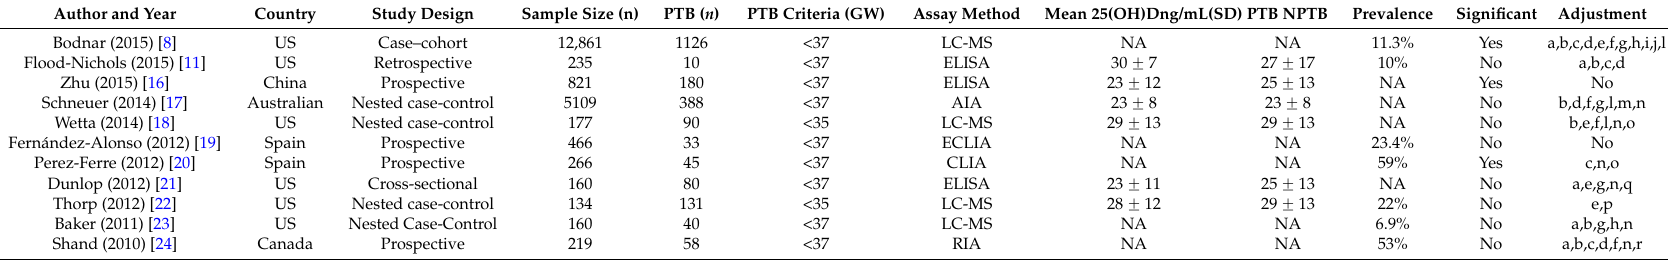
Table 1. Characteristics of observational studies included in this